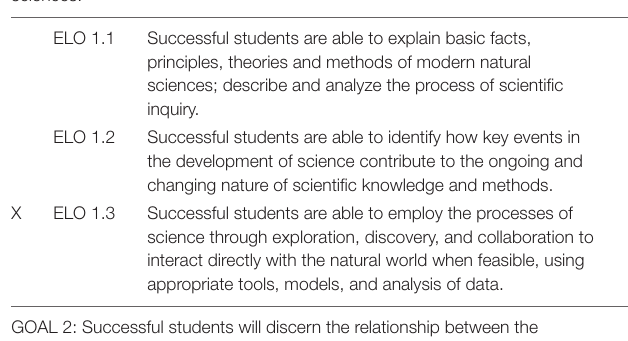
TABLE 2 | Course goals and expected learning outcomes (ELOs) for introduction to environmental science (ENR2100). GOAL 1. Successful students will engage in theoretical and empirical study within the natural sciences, gaining an appreciation of the modern principles, theories, methods, and modes of inquiry used generally across the natural